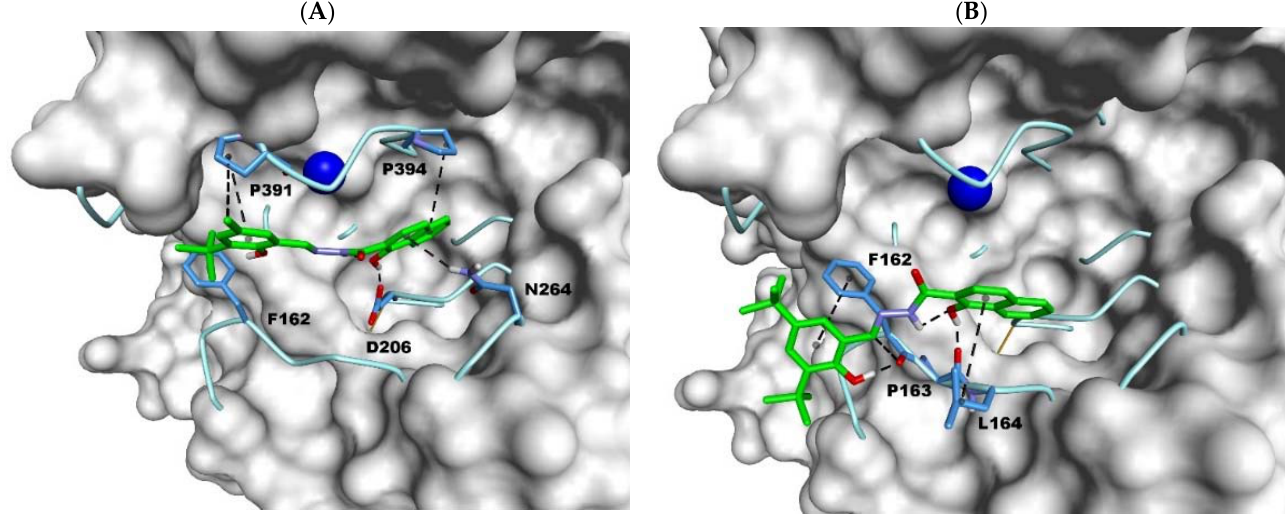
Figure 10. The active center of the laccase (PDB: 1GYC) with the interaction between selected amino acid and inhibitors: 5a ( A ), 5c ( B ). The amino acids are shown as blue sticks, and the protein is shown as a light blue tube, and its surface is colored gray. The Fe ion is shown as a blue sphere. The interactions are black dashed lines.